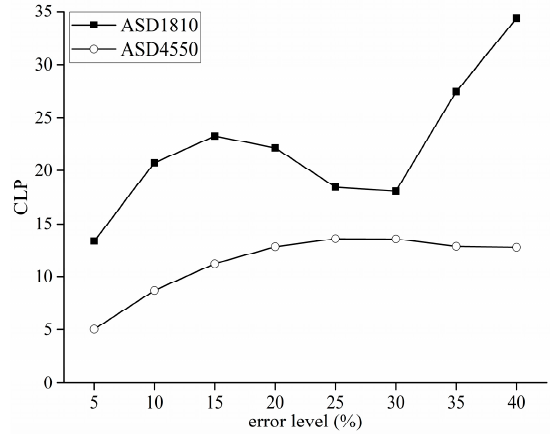
Figure 4. Changes in landscape of the base maps with increasing error. Confidence level probability (CLP) is calculated by Equation (4).